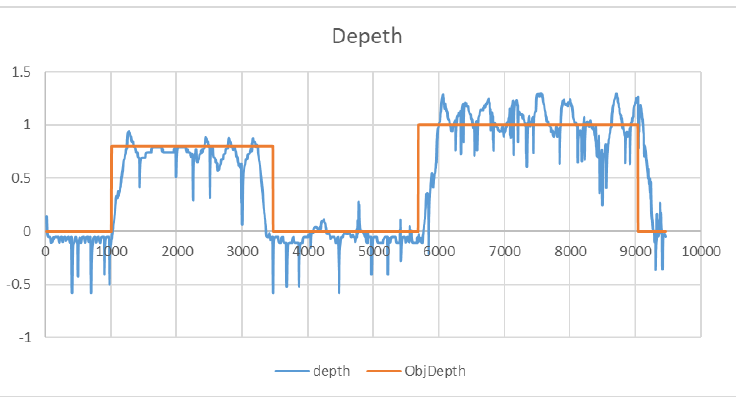
Figure 11. Depth variation curve of fixed-depth experiment.